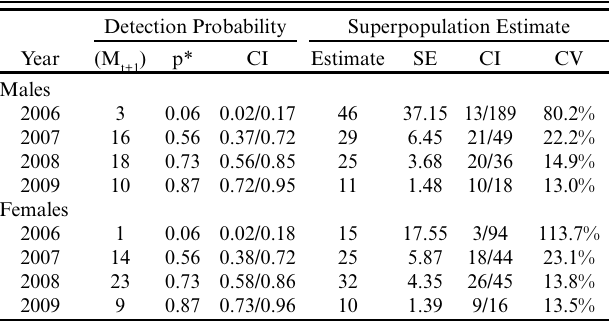
Table 5 . The number of unique bears detected (Mt+1), estimates of detection probability (p*), and corresponding superpopulation estimates for males and females for the Koeye River grizzly bear ( Ursus arctos horribilis ) DNA mark-recapture project 2006-2009. Confidence intervals (CI; upper/lower) and coefficient of variation (CV) are also shown.